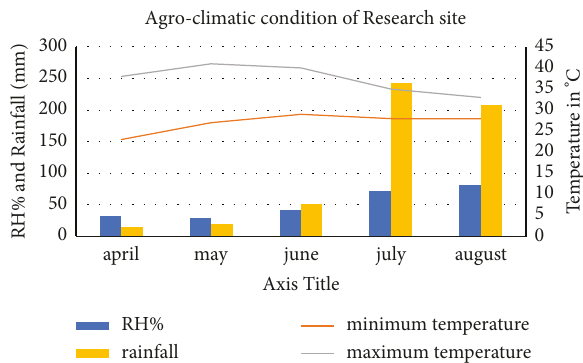
Figure 1: Agro-climatic conditions during the research